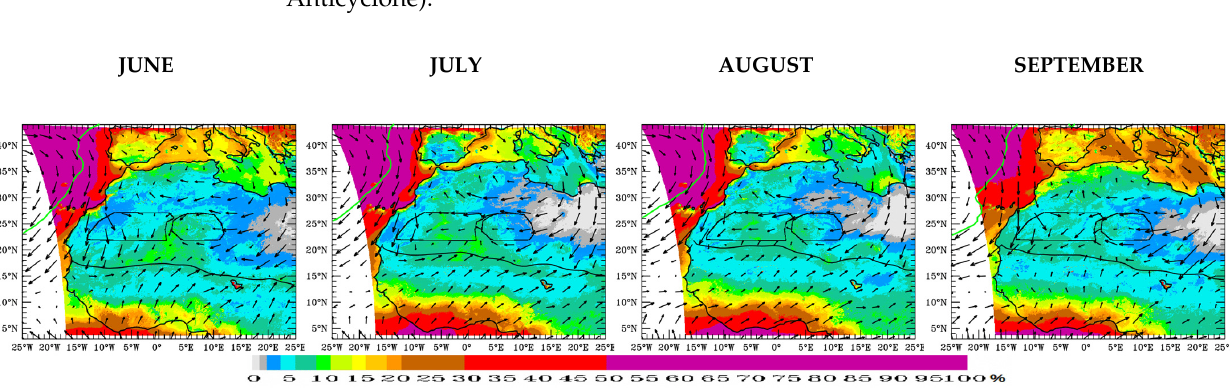
Figure 4. Low-top COF (shadings), inter-tropical discontinuity (ITD, black line), boundaries of the most frequent region for the geopotential at 900 hPa (green line), horizontal wind at 925 hPa (vectors).